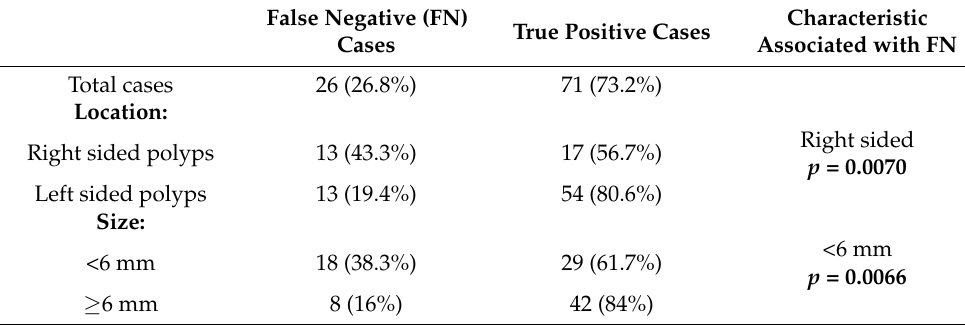
Table 4. Polyp characteristics associated with false negative